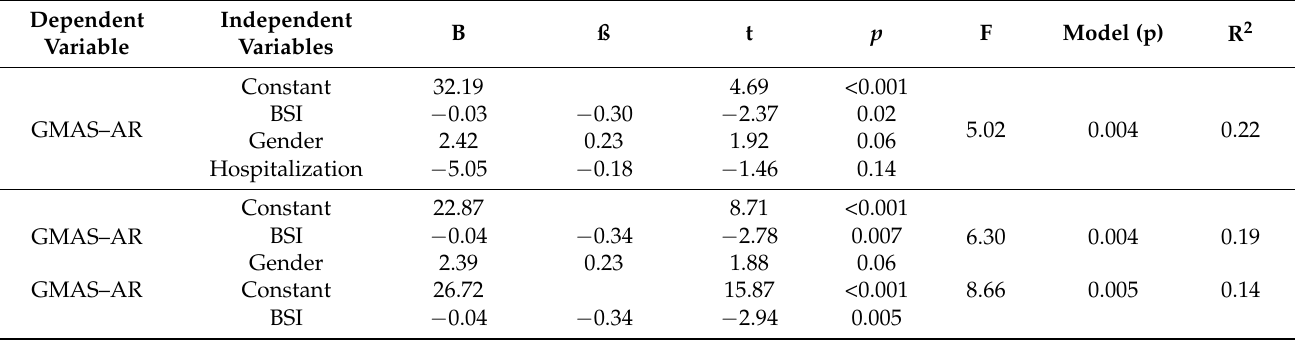
Table 3. The effects of sociodemographic variables and BSI on